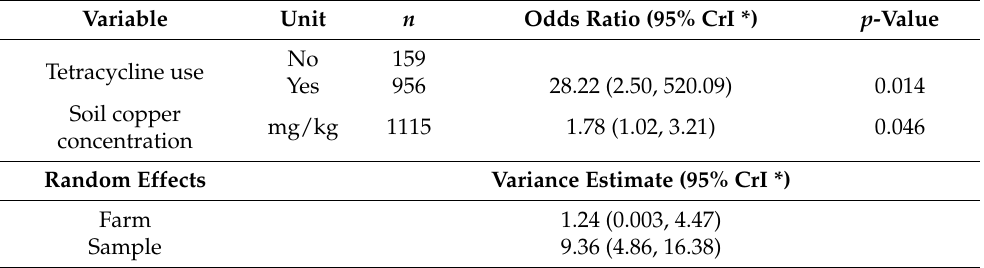
Table 7. Multivariable multilevel logistic regression analysis for risk factors associated with E. coli isolates being defined as non-wild type for